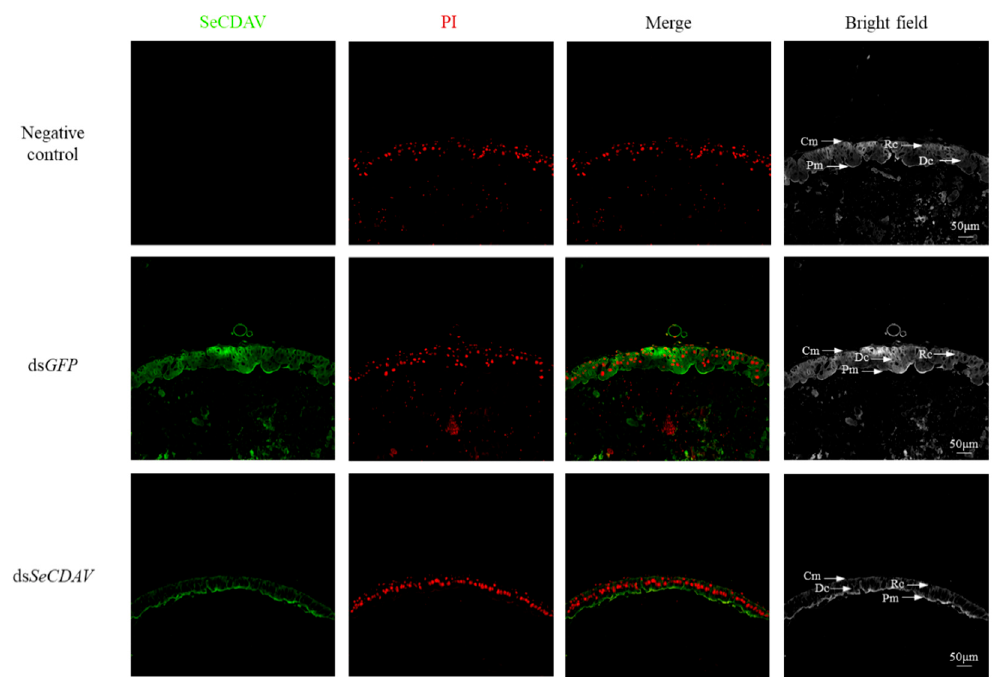
Figure 7. Detection of SeCDAs using a specific antibody. The specific signal of SeCDAs was detected after ds GFP and ds SeCDAV injection into fourth-instar larvae. The negative control was with the pre-immune serum. The SeCDAs protein is represented by green and the cell nucleus by red. Cm: circular muscle; Pm: peritrophic membrane; Rc: regenerative cells; Dc: digestive cells; scale bar is 50 μ m.